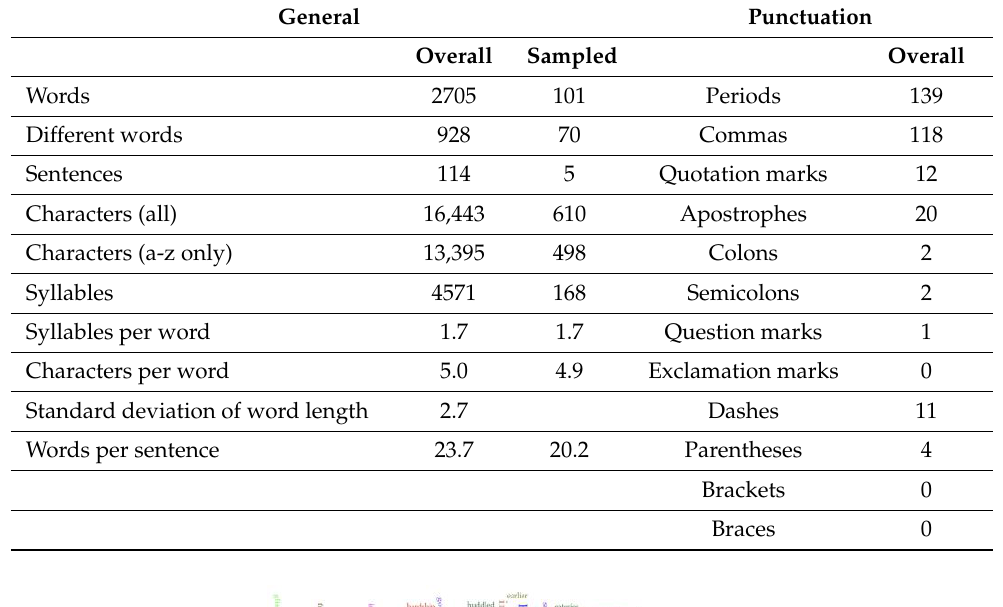
Table 2. Text Statistics for Blog (Source: Lumos Text Complexity Analyzer).